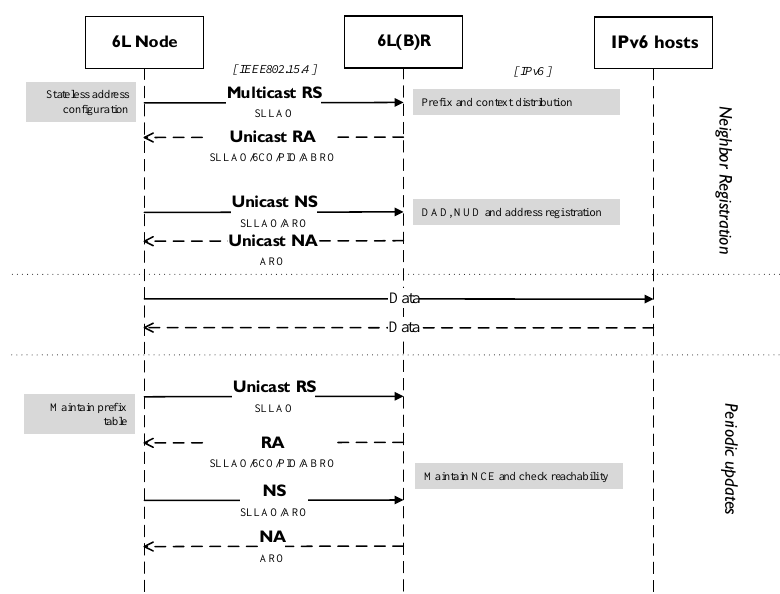
Figure 3. 6LoWPAN optimized neighbor